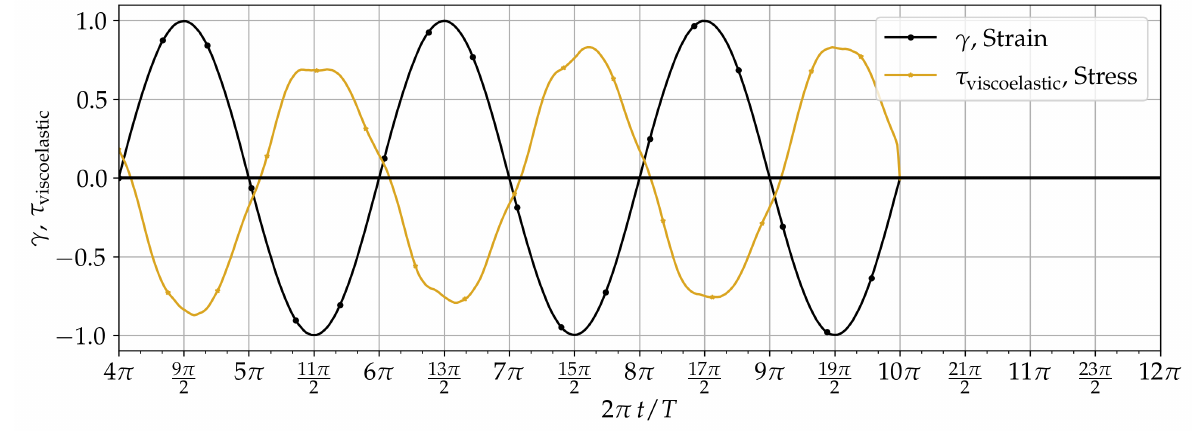
Figure 18. Shear stress τ and strain γ vs. time for a viscoelastic case.